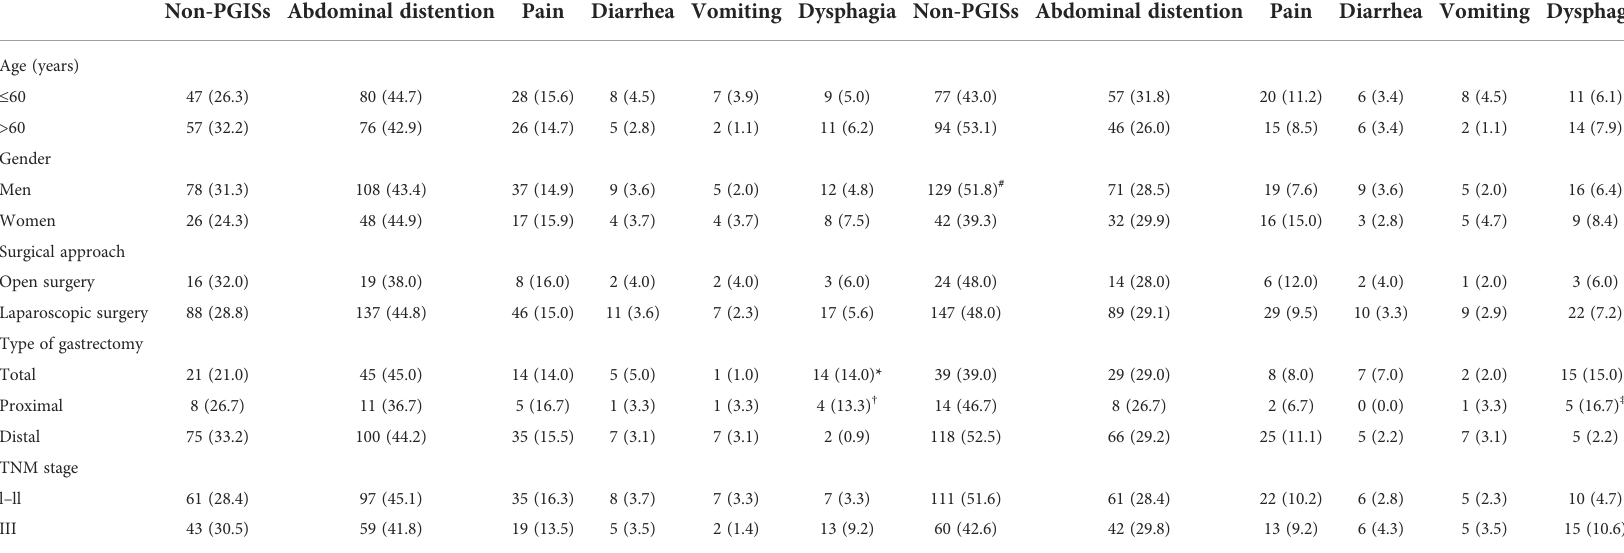
TABLE 2 The relations between PGISs and clinical